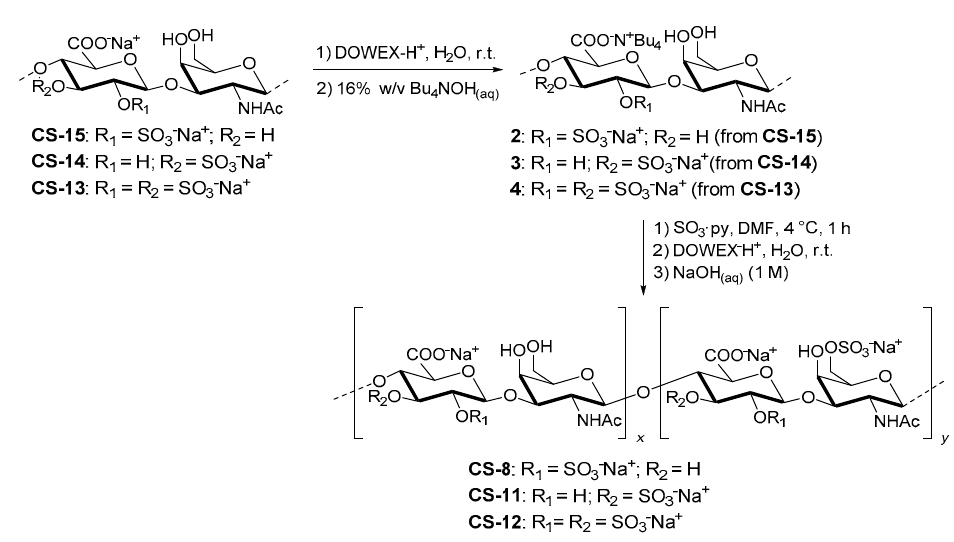
Figure 4. Scheme of the synthesis of CS-8, CS-11 and CS-12.